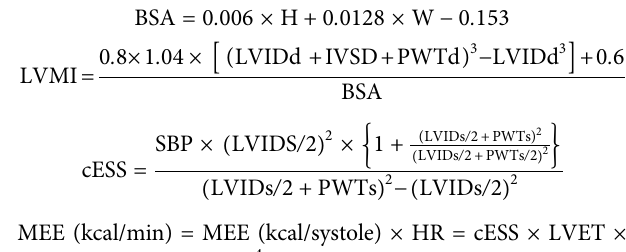
population. Variables